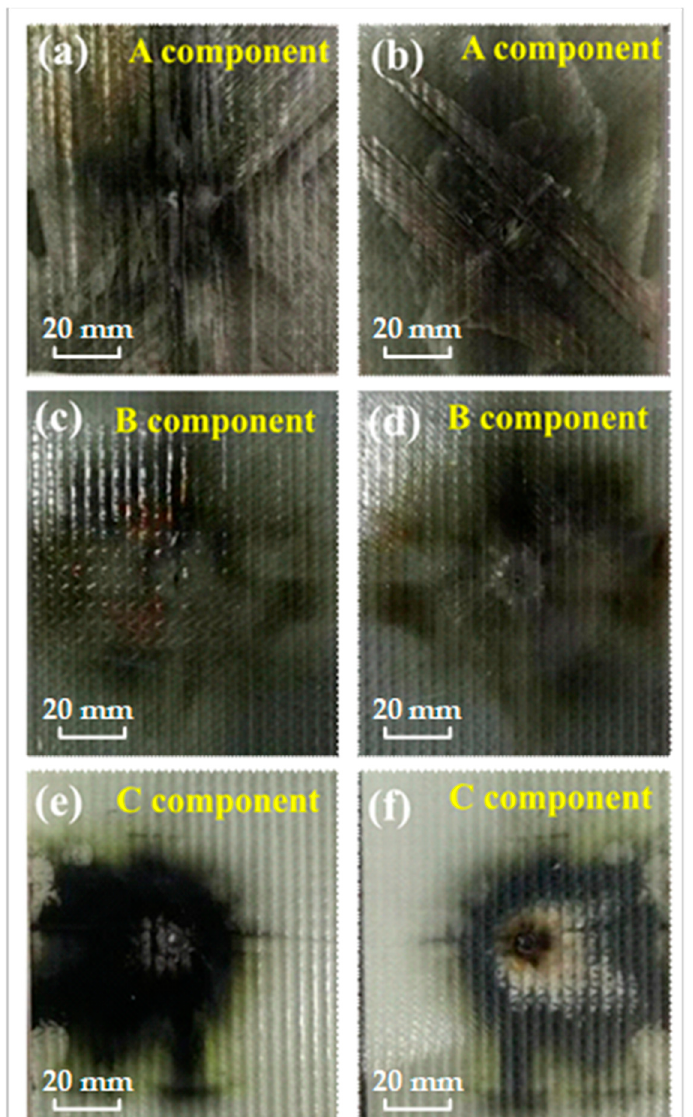
Figure 14. The experimental results of the through-discharge of the GFRCs under different lightning current components: ( a , b ) A component; ( c , d ) B component; ( e , f ) C component.